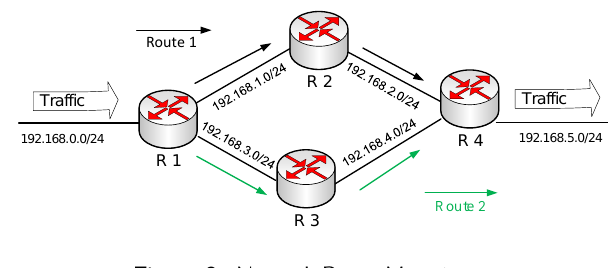
Figure 3. Network Route